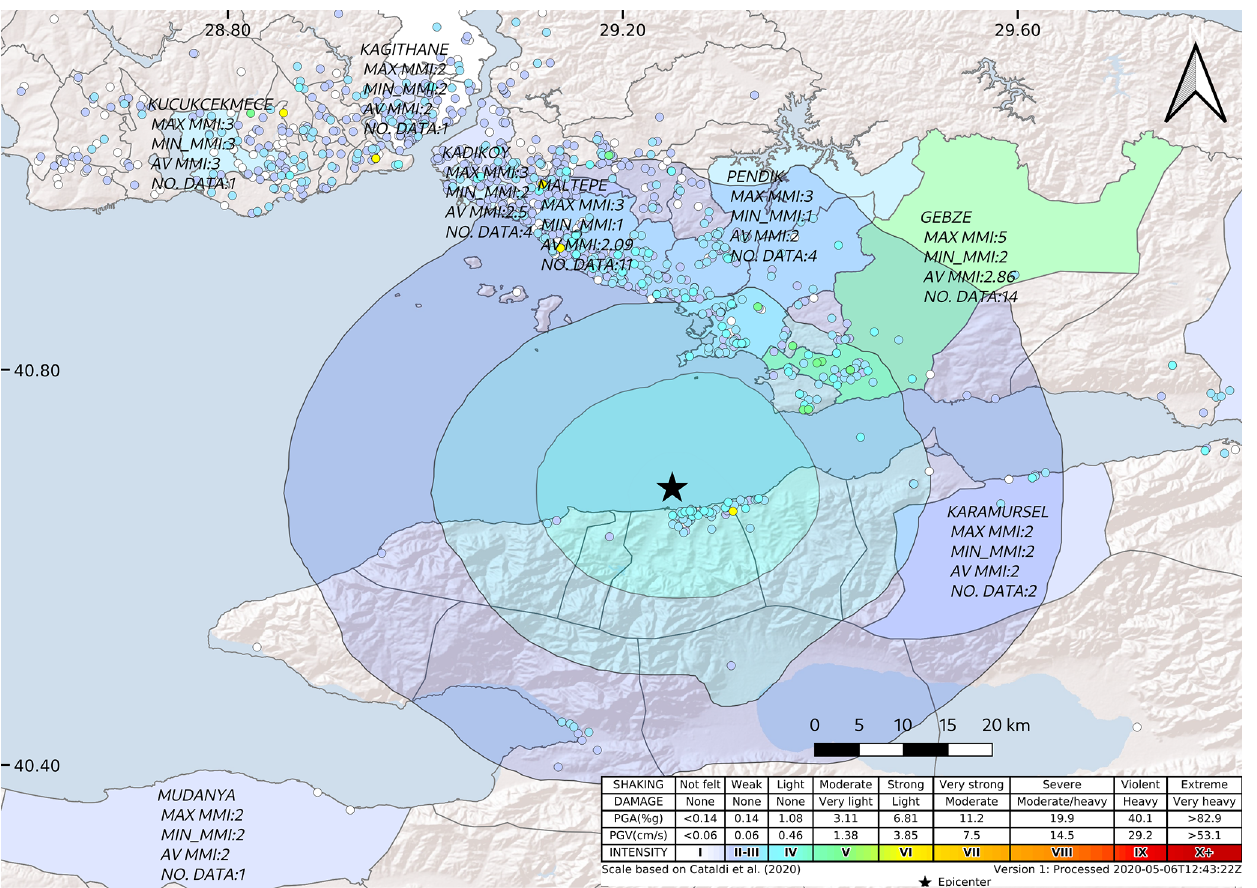
Figure 5. Intensity map of the 10 October 2019 Yalova earthquake with labeled entries. Entries are plotted to district level polygons. Felt reports of the earthquake submitted to EMSC are at the top of the labeled entries (created using QGIS).